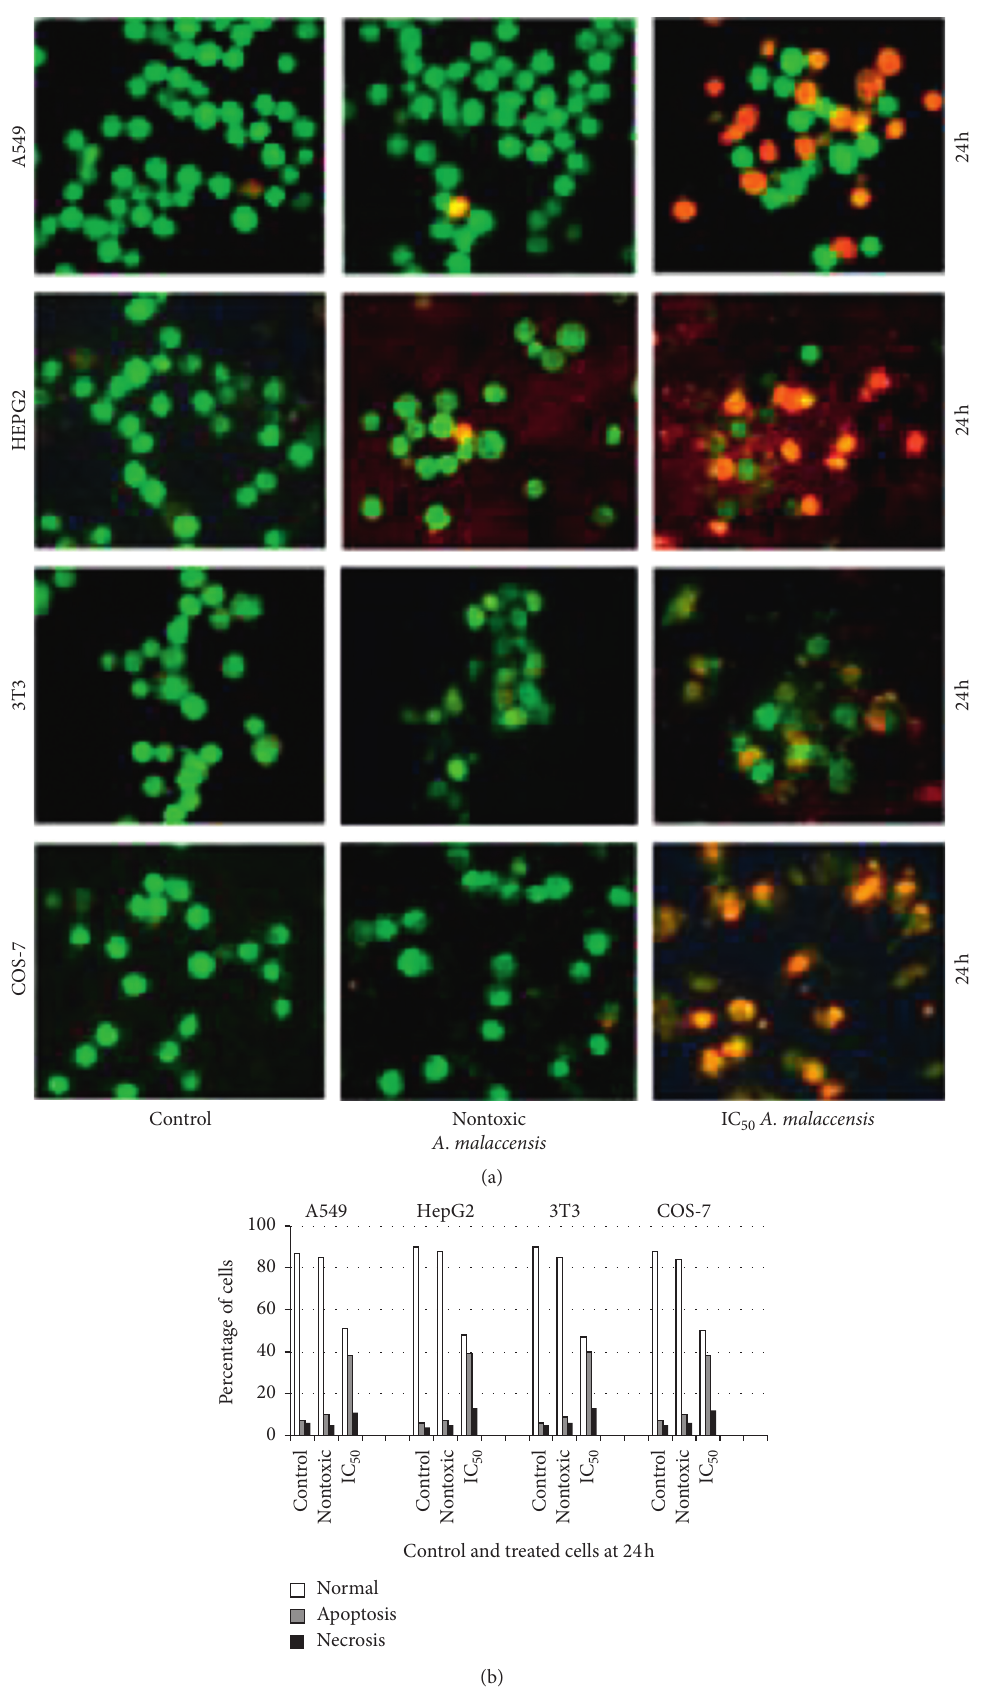
Figure 2: Assessment of apoptosis and necrosis. (a) Cells exposed to A. malaccensis extract and observed adopting AO/EB staining. Control cells are viable and fluoresce uniformly in green; cells in apoptosis fluoresce from yellow to orange; necrotic cells are swollen and fluoresce in bright red. (b) Percentage of normal, apoptotic, and necrotic cells. Data are expressed as the average of three independent